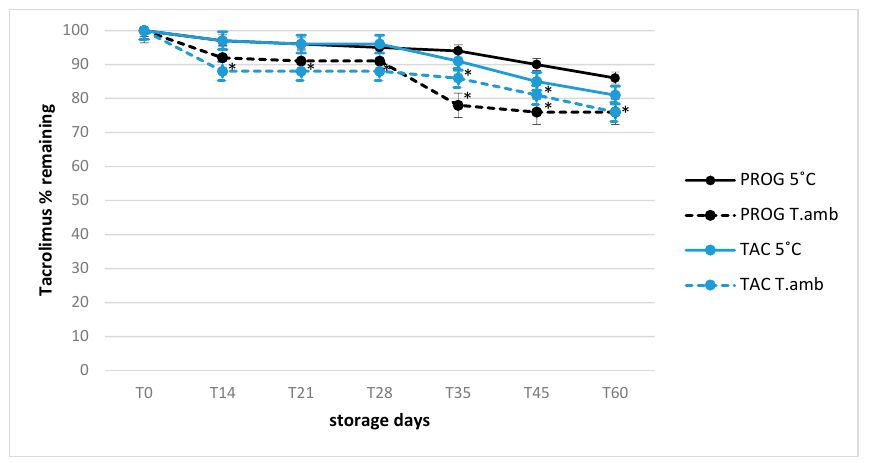
Figure 1. ( A ) Ion chromatograms extracted from full scan (FS), chromatograms of main fragment obtained by mass spectra MS 2 acquisition and mass spectra of proadifen (SKF-525A), tacrolimus and cyclosporine A (100 ng/mL). ( B ) q-Exactive Orbitrap high-resolution mass spectrum and